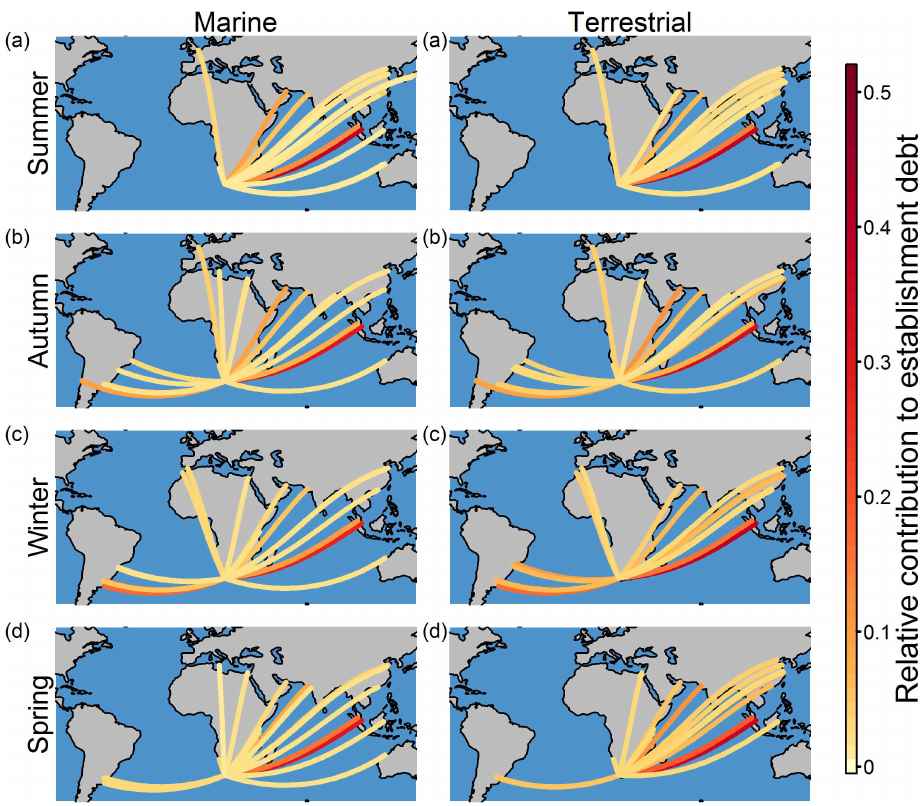
Fig 3. The twenty shipping routes from foreign ports, for each season, with the highest relative contribution to the marine and terrestrialestablishment debt of Saldanha Bay. Seasons are basedon those of the southernhemisphere: (a) summer, (b) autumn, (c) winter and (d) spring. The depictedroutes are not the actual routes followedby